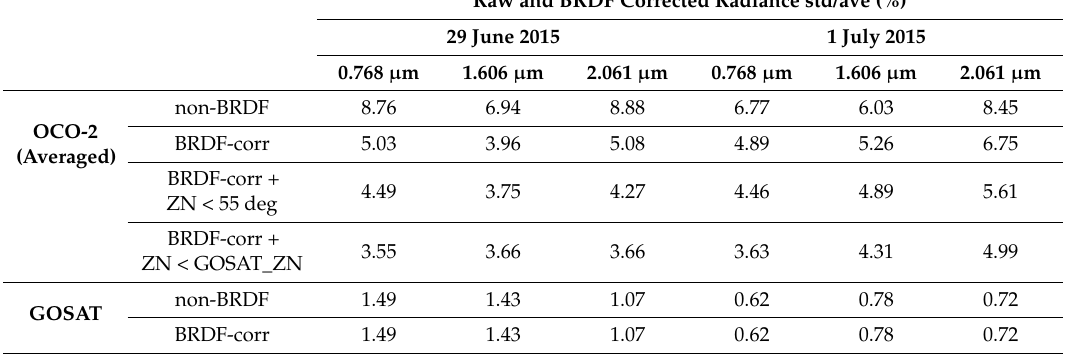
Table 4. The same as Table 3 but with the coefficient of variation of radiance instead of averaged spectral radiance. The coefficient of variation of radiance is the sample standard deviation over the sample